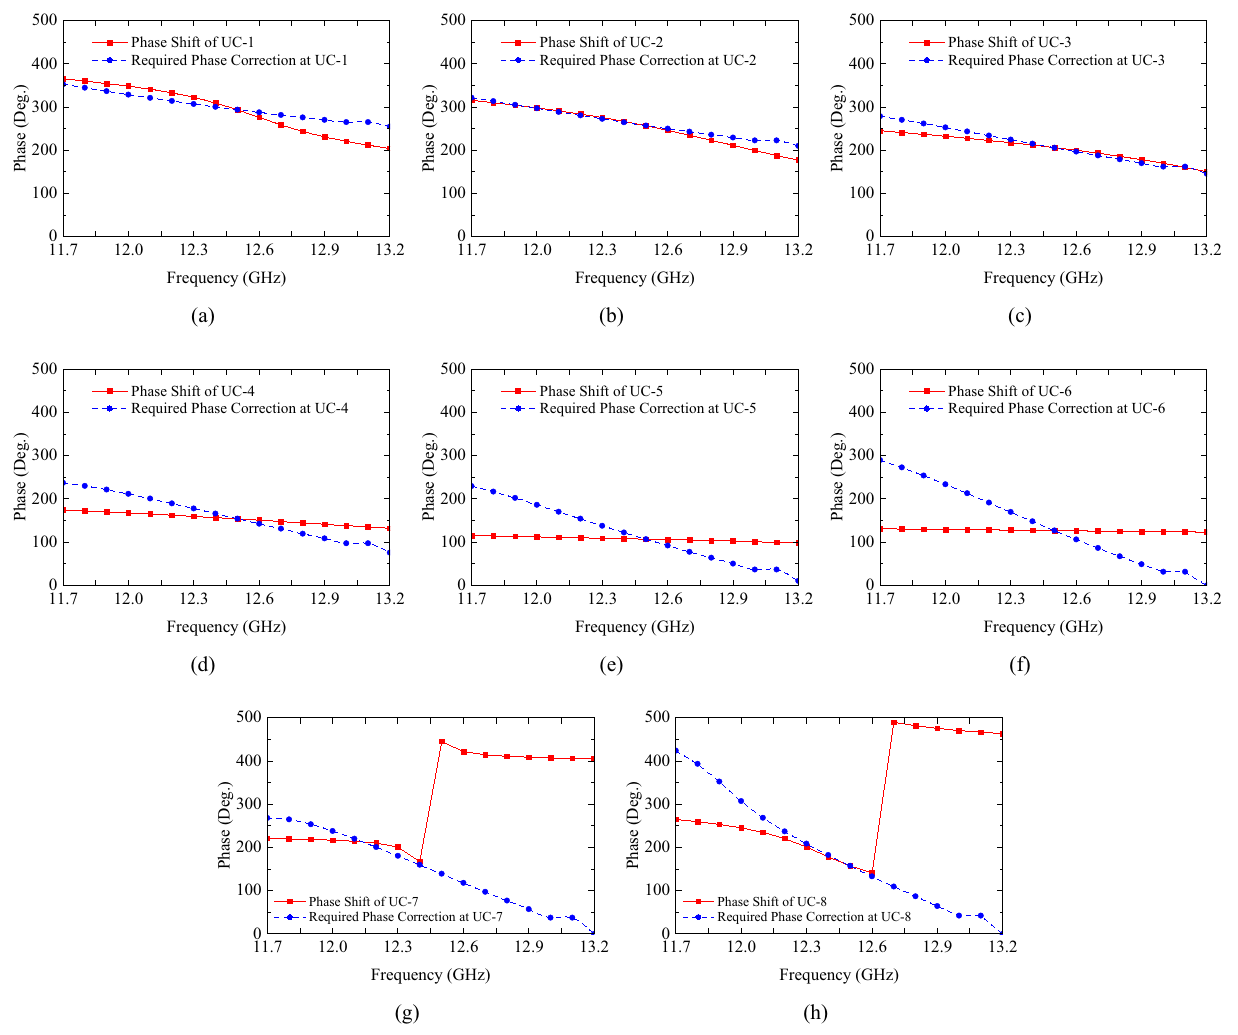
Figure 10. Phase shift of each P-PSC and the phase correction required in the RCA aperture at each P-PSC location versus frequency. (UC-1 is at the center of the antenna aperture and UC-8 is the outermost).